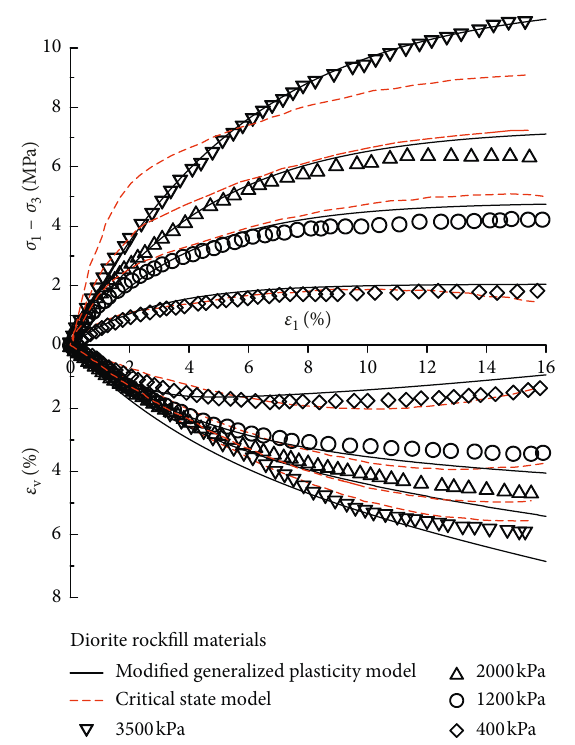
Figure 3: Comparisons between test results and prediction results of two